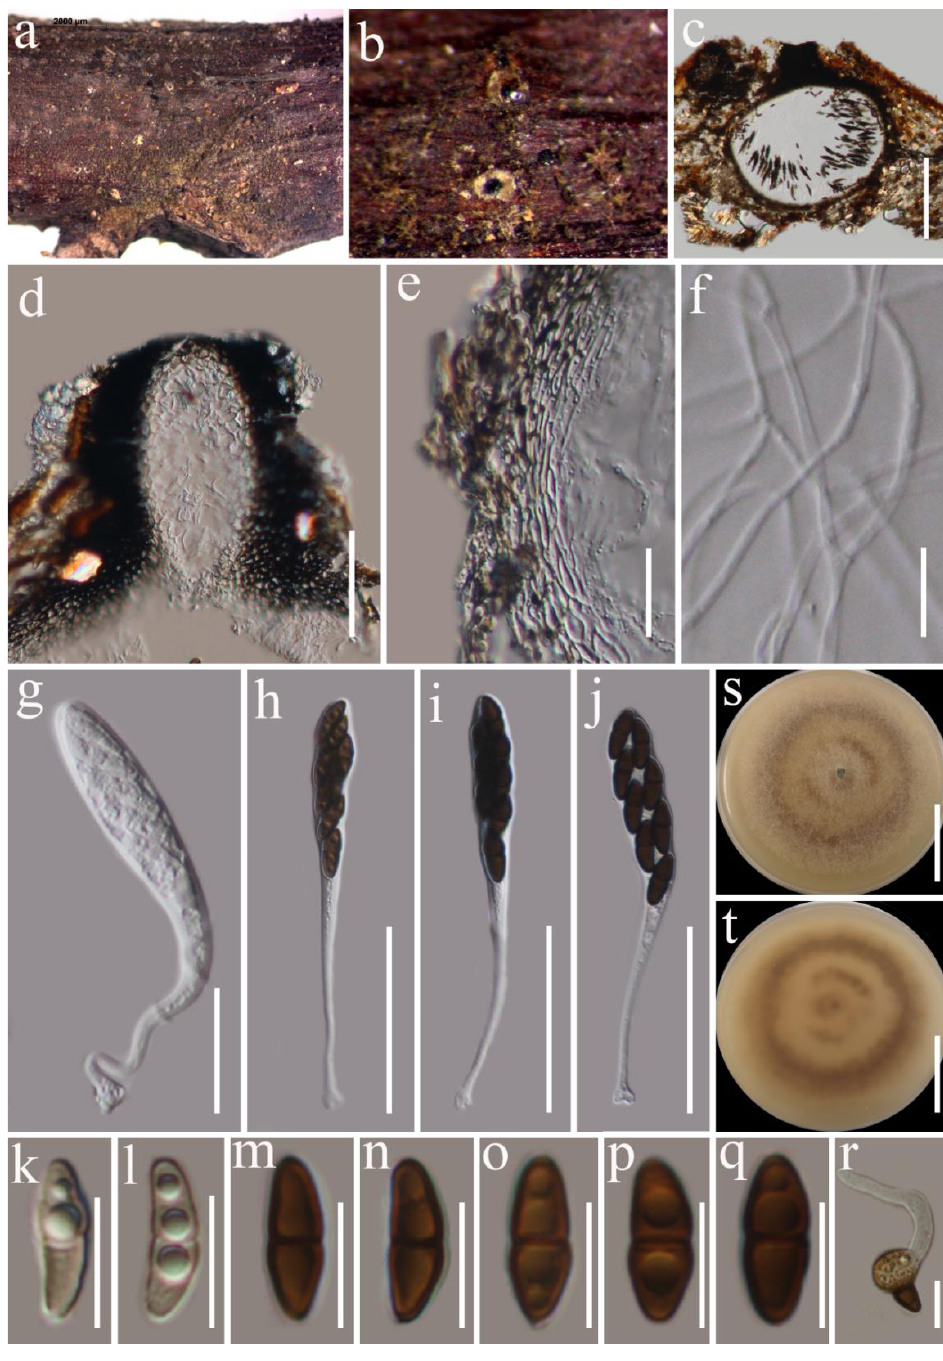
Figure 7. donacina (HKAS 122782). ( a , b ) Appearance of ascomata on host substrate; ( c ) section of ascoma; ( d ) ostiolar neck; ( e ) peridium; ( f ) hamathecium; ( g – j ) asci; ( k , l ) immature ascospores; ( m – q ) mature ascospores; ( r ) germinated ascospore; ( s , t ) culture characters on PDA ( s from above, t from below). Scale bars, ( c ) 200 µ m; ( d , h – j ) 50 µ m; ( e , g ) 20 µ m; ( f , k – r ) 10 µ m; ( s , t ) 30 mm. Culture characteristics: Colonies on PDA, reaching 90 mm diam. at 14 days at room temperature (25–30 ◦ C), superficial, circular, rough surface, with sparse mycelia, velvety, flat, zonate, white at the margin and center, light brown between margin and